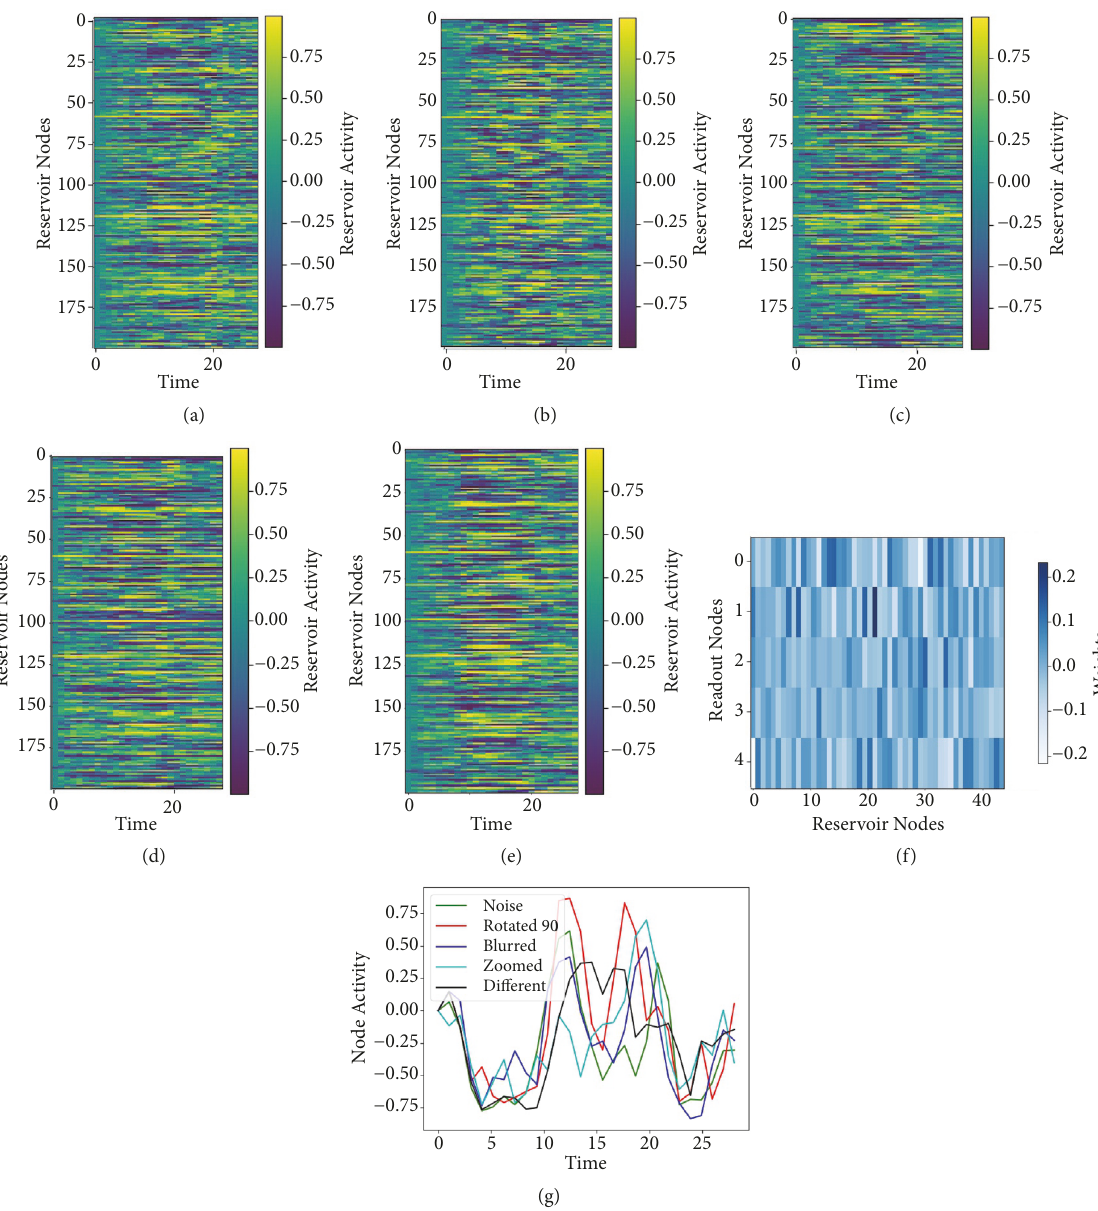
Figure 11: Reservoir activity for the single reservoir architecture.(a), (b), (c), (d), and (e) show the differential reservoir activity of 200 nodes over 28 timesteps for input relationships noise, rotated, zoomed, blurred, and different, respectively. (f) shows the output weight matrix( 𝑊 out ) for 50 reservoir nodes. (g) shows activity of a random node for all output labels over 28 timesteps. 𝑁 𝑅 : 1000; 𝛾 = 0.5 ; sparsity = 0.9